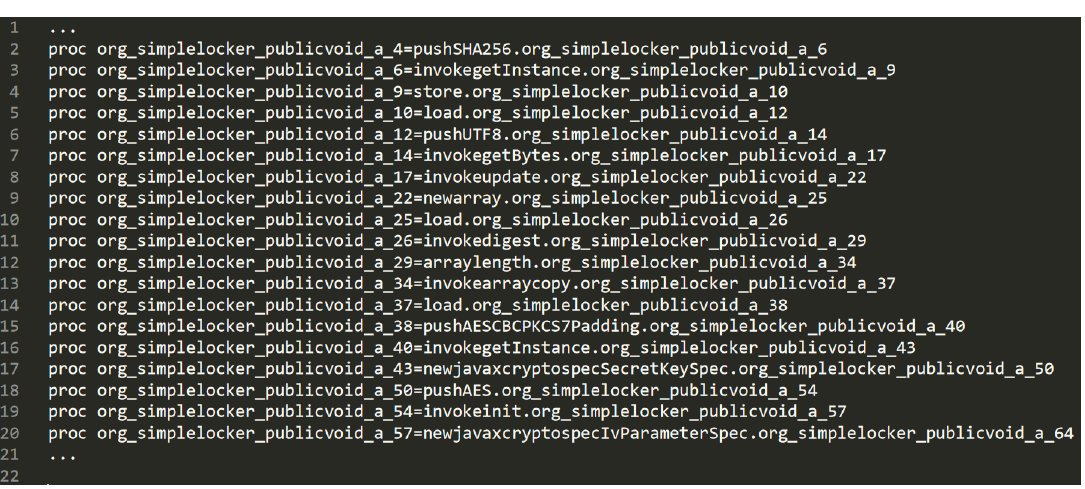
Figure 3. A Control Flow Graph (CFG) automaton fragment obtained from the Java bytecode shown in Listing 4.